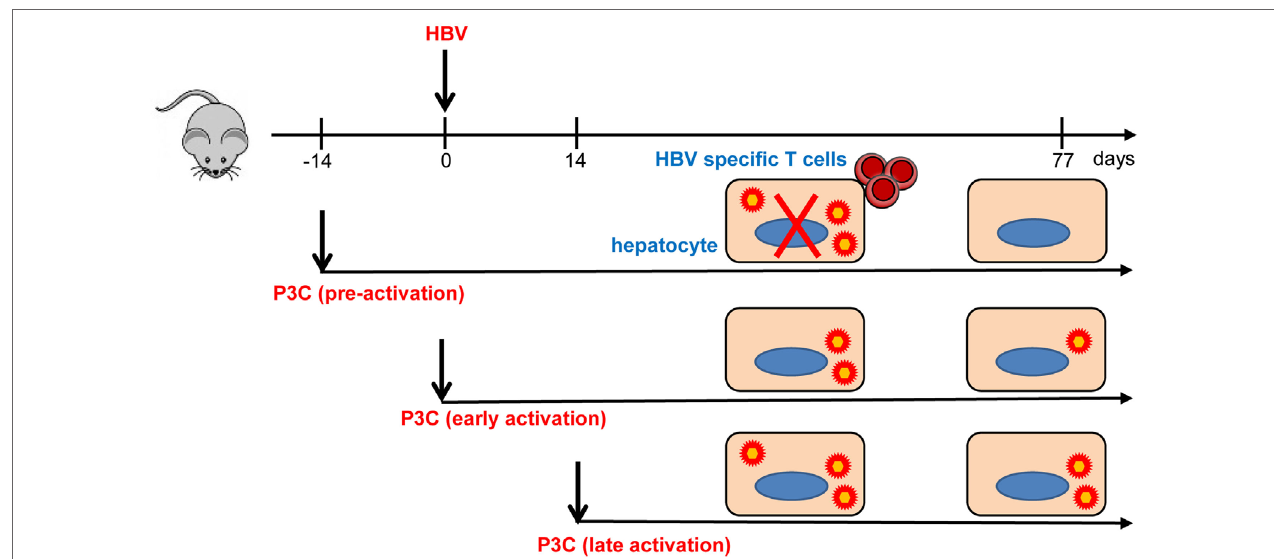
FigUre 7 | Toll-like receptor 2 (TLR2) activation promotes CD8 + T-cell responses and hepatitis B virus (HBV) clearance in mouse model. Pre-activation of TLR2 by P3C leads to enhanced HBV-specific CD8 + T cell responses and HBV clearance in the mouse model. P3C application at the early stage achieves HBV clearance in some mice in the model for persistent HBV replication. However, activation of TLR2 at a late time point does not inhibit HBV replication at all. TLR2 activation itself may only exert weak anti-HBV activity and could not provide help for HBV-specific T cell response if not prepared in